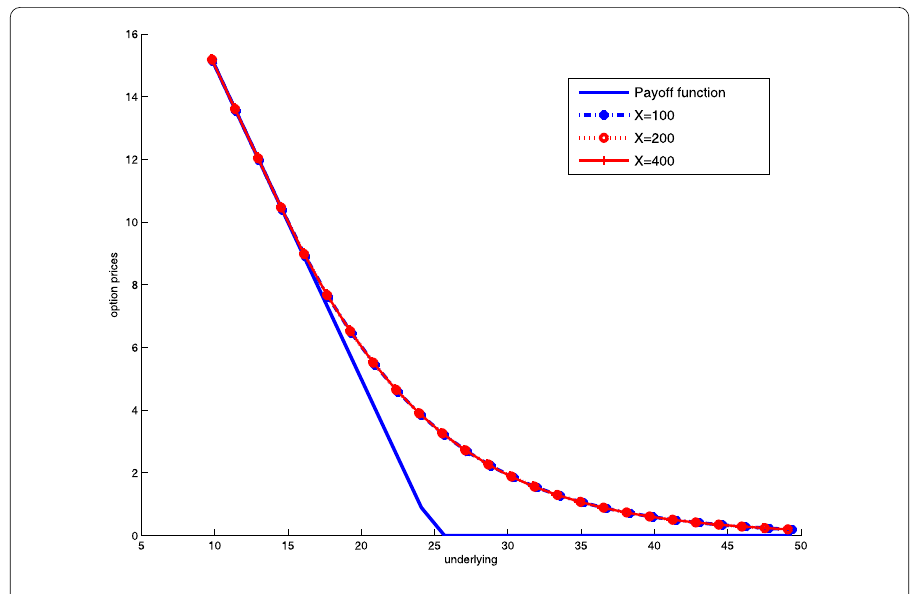
Figure 2 Impacts of the truncation of the domain. Model parameters are σ = 0.3, r = 0.1, D = 0, T – t = 1(year), E =